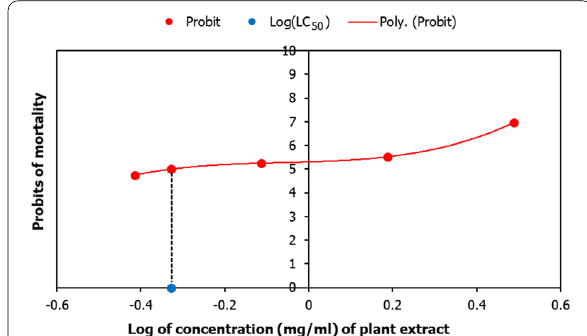
Fig. 1 Lethal concentration (LC 50 ) of Convolvulus pluricaulis . The graph depicts the relationship between probit mortality and the concentration of Convolvulus pluricaulis (CP) (depicted as solid circles). The binomial response (death/no death) of 24 hpf embryos exposed to the plant extract was recorded over 48 h. The solid line represents the third-order polynomial equation that modeled the